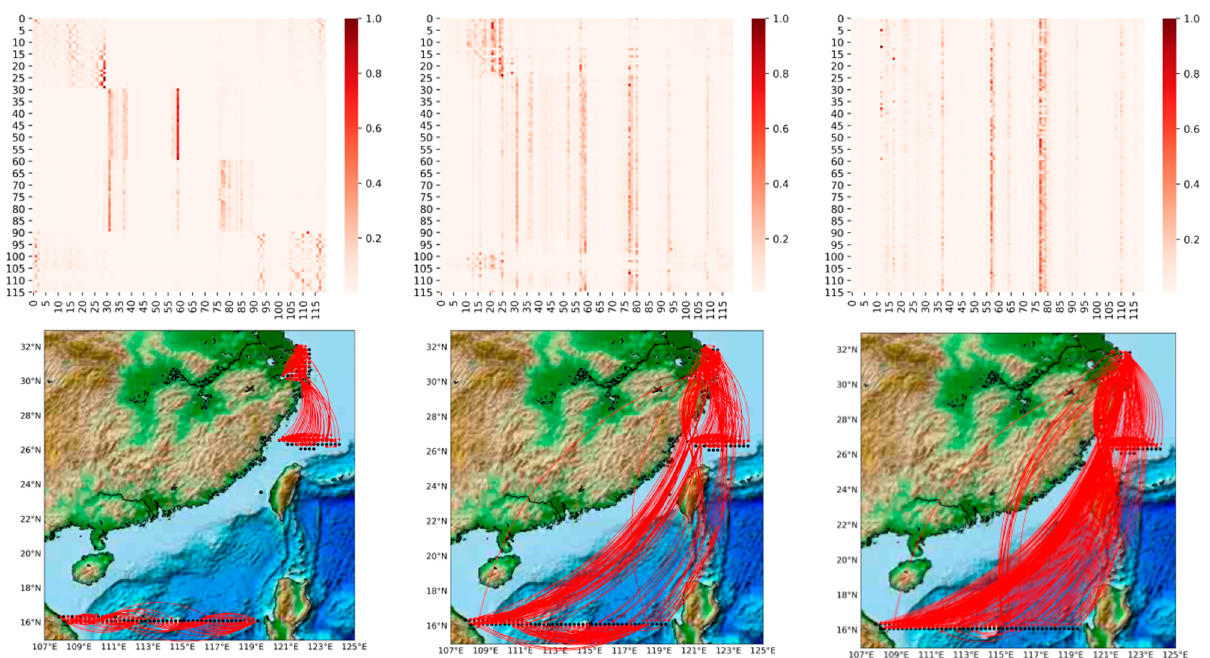
Figure A1. The learned graph structure (120 nodes) at different prediction scales (from left to right 6 h, 96 h (4 d), and 168 h (7 d)).